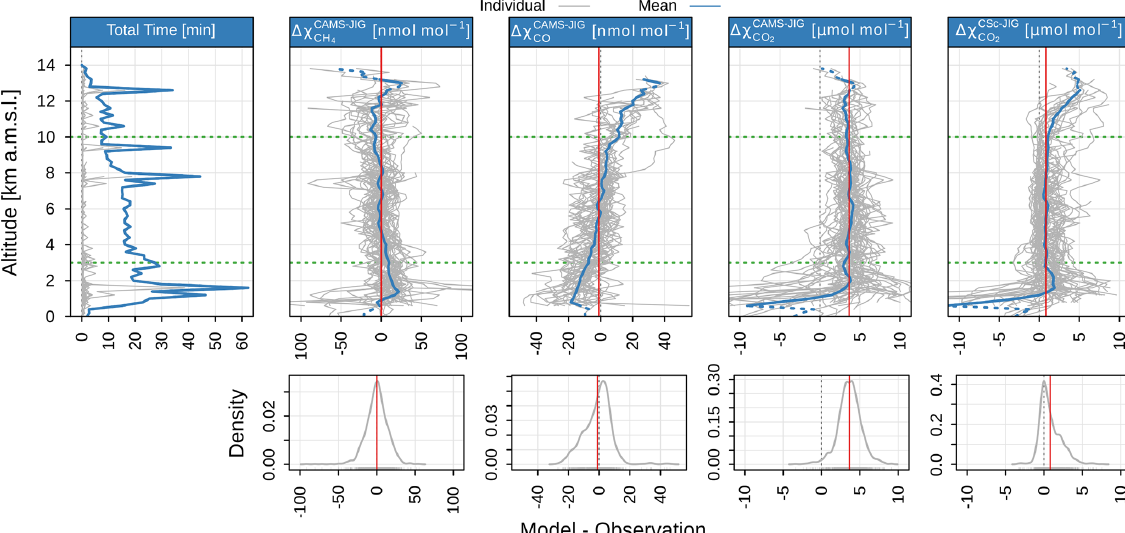
Figure 6. Top row: the first panel shows time spent in each altitude bin (200m) for individual flights (grey lines) and the sum for CoMet 1.0 (solid blue). The four panels to the right show differences between modelled (CAMS and CarboScope, latter abbreviated as CSc) and mea- sured mole fractions as a function of altitude (grey – individual flights, blue – average per altitude bin). Dashed red line represents the average value in the altitude range 3–10km (vertical range marked with horizontal dashed green lines). Bottom: density plots for measurements in the free tropospheric (3–10km)